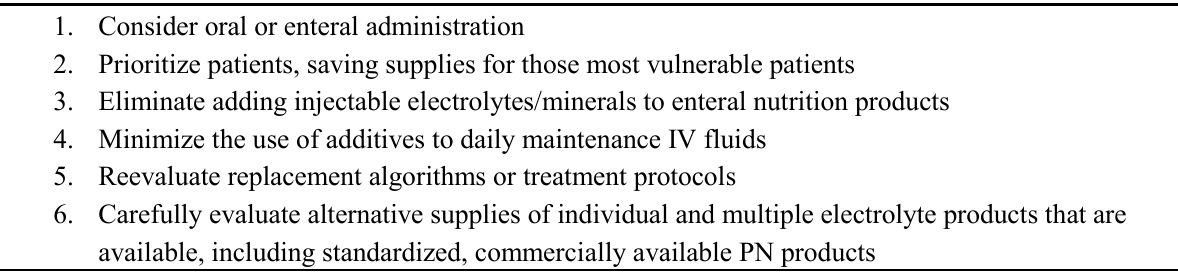
Table 2. ASPEN Recommendations for Conservation of PN